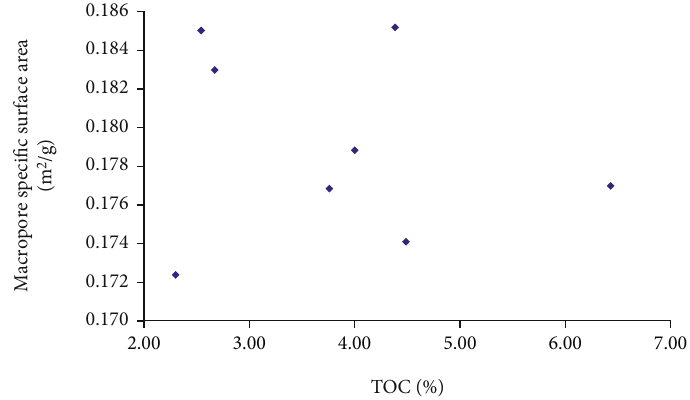
Figure 10: The relationship between the TOC and the macropore speci fi c surface